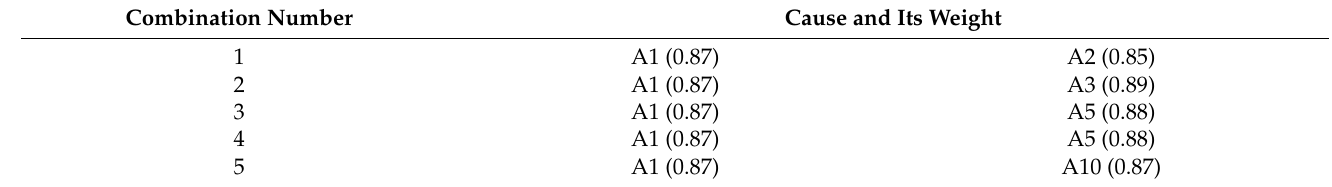
Table 7. Combinations of integrated significant causes of porosity cluster on the mechanical